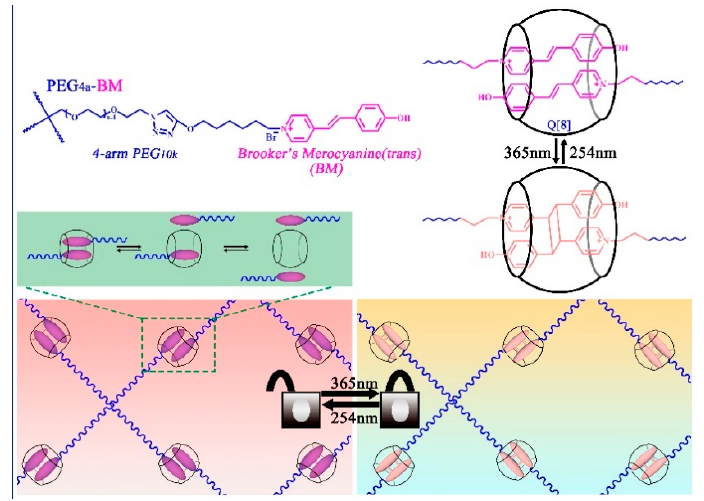
Figure 3. Light-controlled supramolecular hydrogels.